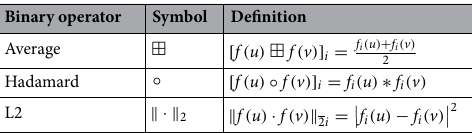
Table 1. Binary operators and definitions adopted from 20